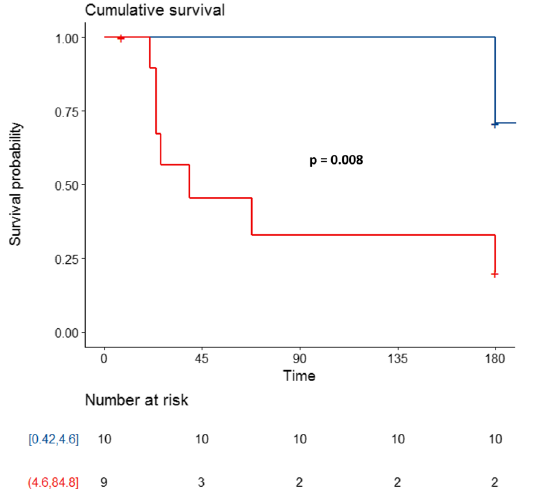
Fig. 1 Adjusted influence of MTX dosage at